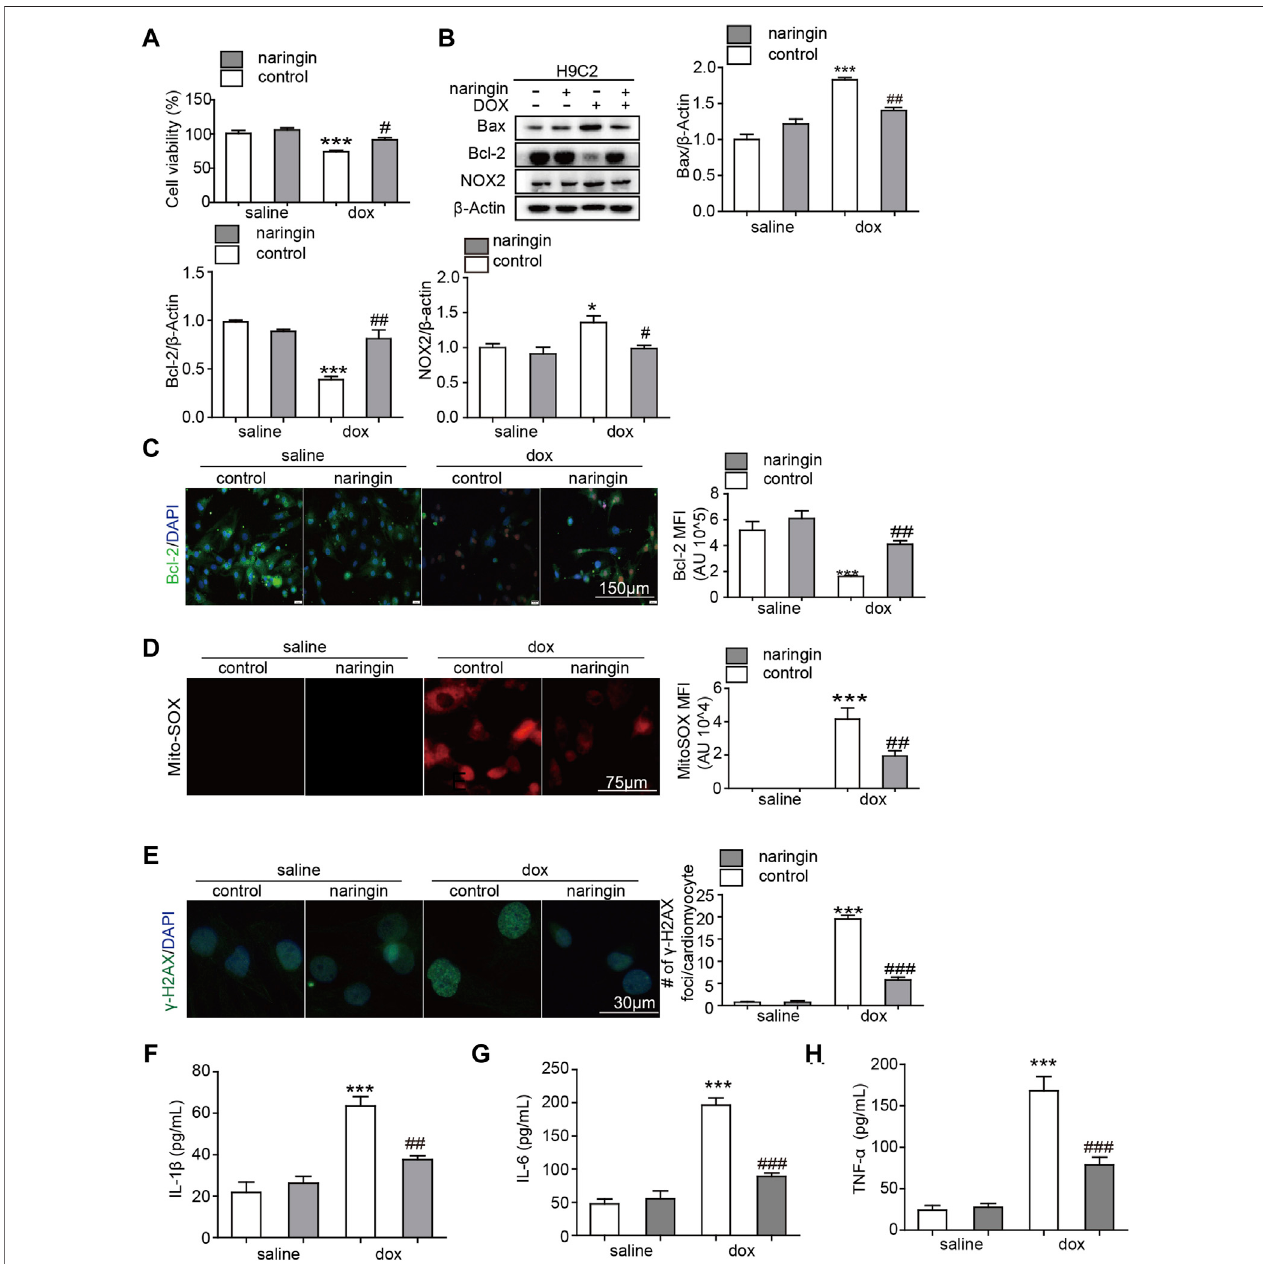
FIGURE 4 | Naringin inhibits the effect of DOX on apoptosis, in fl ammation and Oxidative stress in vitro (A) Effect of Naringin on H9C2 cells in the presence ofDOX. Cellcountingkit8-basedcellviabilityassaysshowCellviabilityofH9C2cellsinthepresenceofDOX. (B) EffectsofNaringinontheproteinexpressionlevelsofBcl-2,Bax and NOX2 in H9C2 cells (left panel) with quanti fi cation analysis (right panel). (C) Naringin treatment increases Dox-Induced Bcl-2 Secretion in NRVMS, which displays representativeimagingofbcl-2immuno fl uorescencestaining.Bcl-2cellsareingreen, DAPIinblue. (D) RepresentativeMito-SOX fl uorescenceimagesindicatethe level of mitochondrial damage (left panel) with quanti fi cation of Mito-SOX fl orescence intensity. (E) Representation image of IF staining of the DNA damage markers γ - H2AX (left panel).The averagenumber of γ -H2AX foci in γ -H2AX-positiveNRVMS. (F – H) The level ofIL-1 β , IL-6and TNF- α detected byELISA. *** p < 0.001DOX versus control group; ## p < 0.01, and ### p < 0.001 DOX versus NR + DOX.